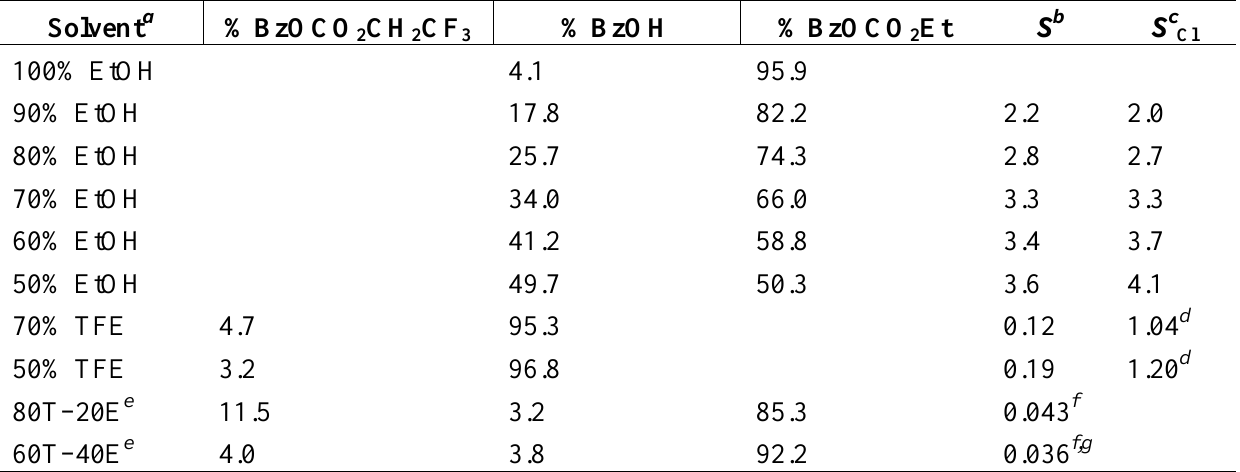
Table 2. Percentages of the products present after the solvolysis of benzyl fluoroformate (BzOCOF) in a binary hydroxylic solvent at 25.0 °C and the calculated selectivity